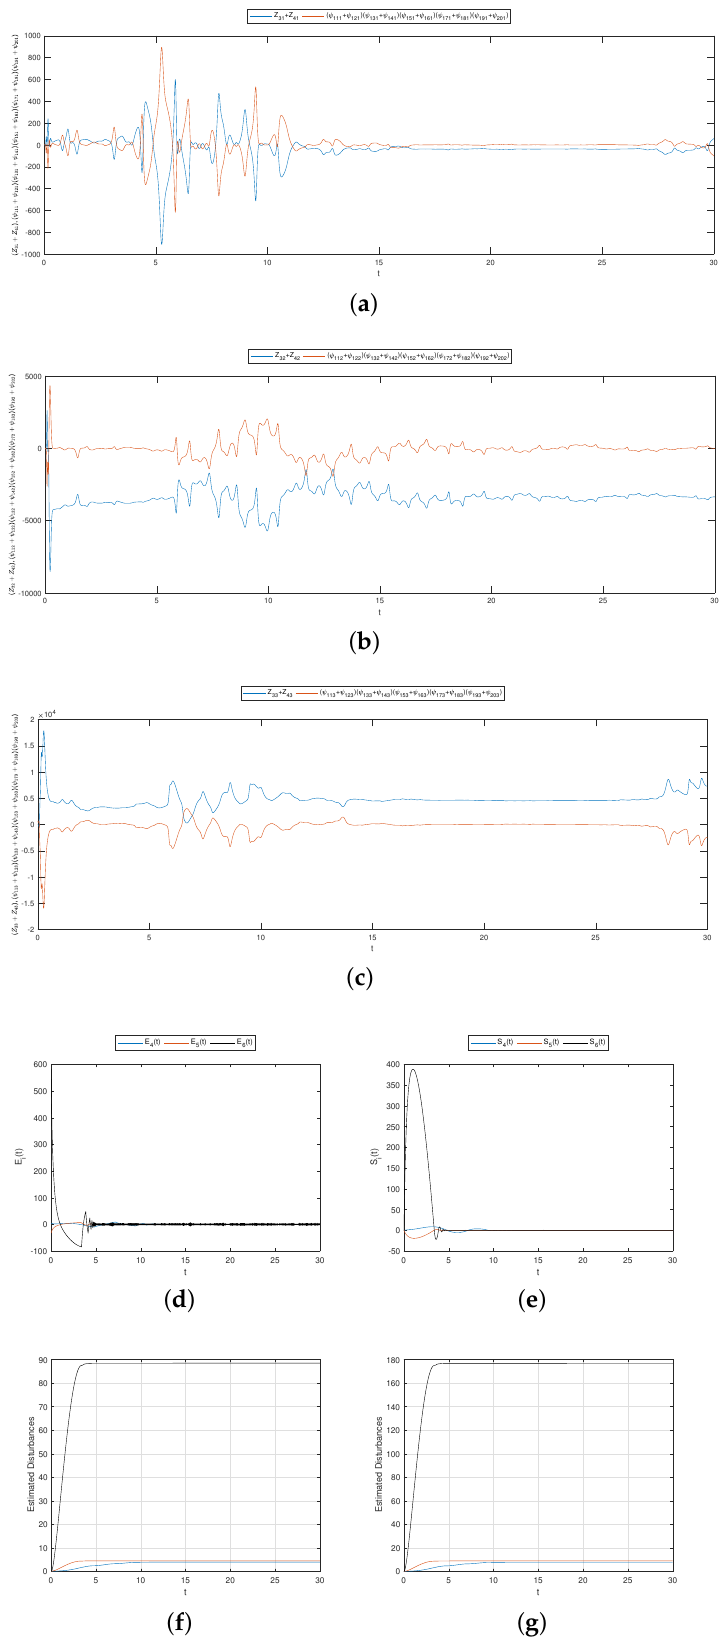
Figure 9. ( a – c ) Synchronized trajectories via adaptive sliding mode control. ( d ) Error. ( e ) Surface converging to zero. ( f , g ) Disturbance